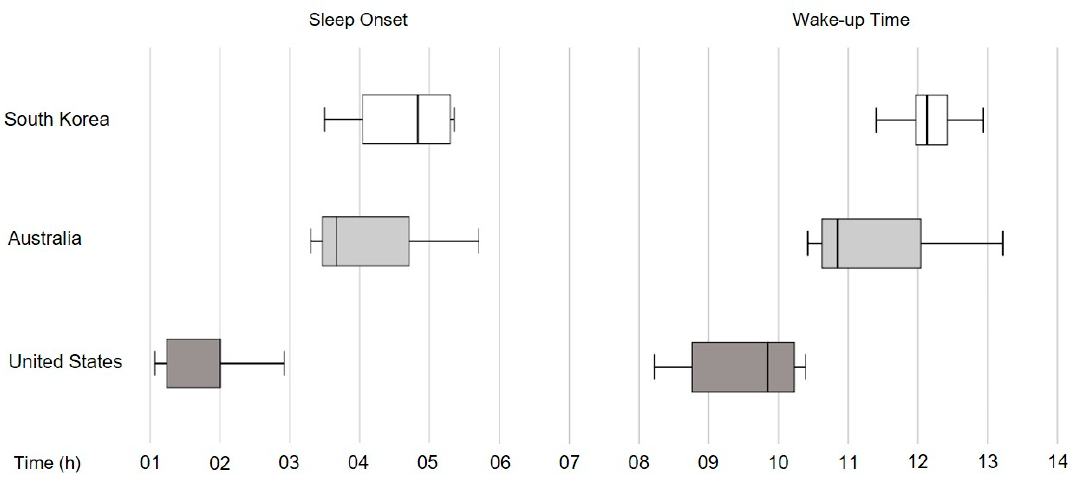
Figure 1. Differences in sleep onset and wake-up times.